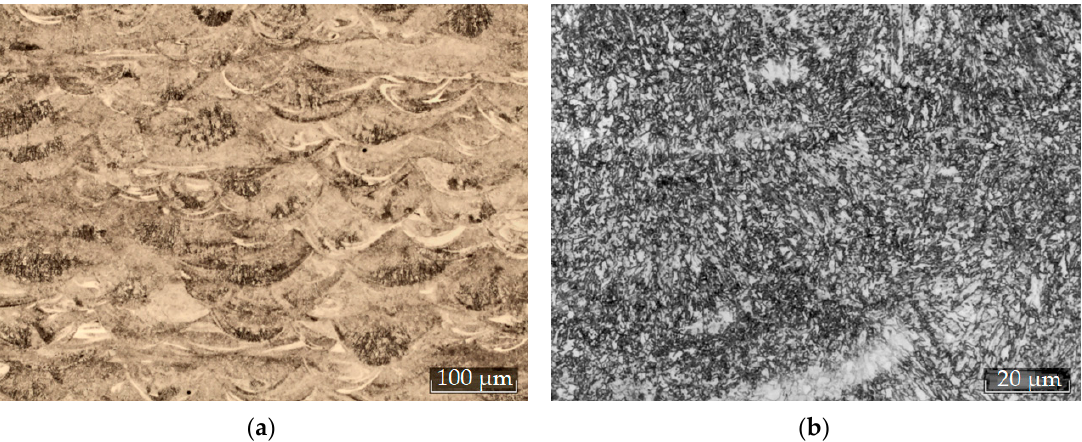
Figure 5. Optical microscopy of 20kH13 (AISI 420) steel sample after laser powder bed fusion: ( a ) 200×; ( b ) 1000×. ( b ) 1000 ×